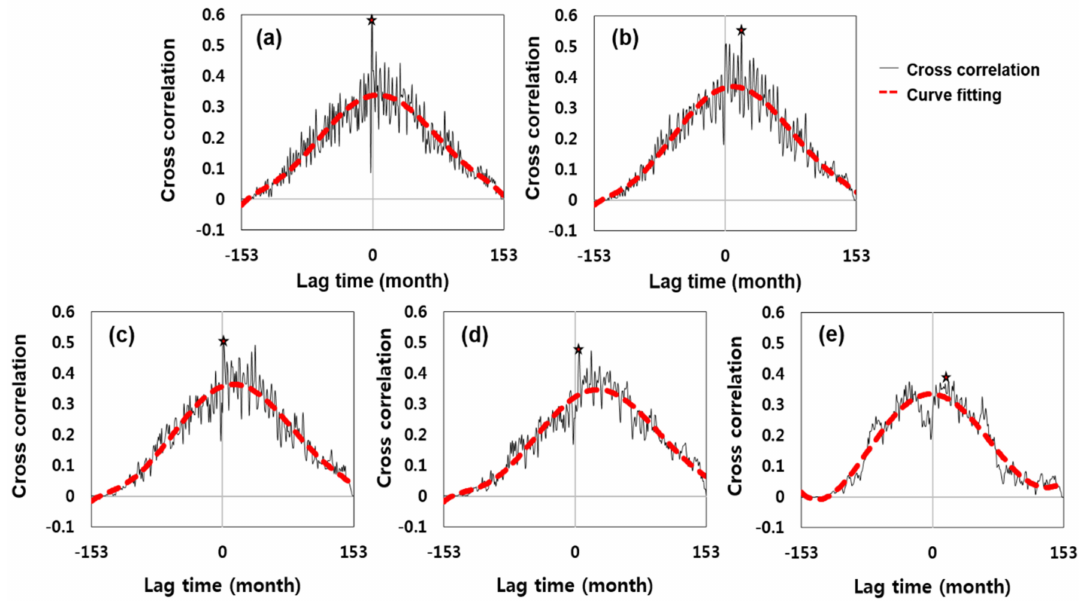
Figure 10. Cross-correlation between SPEI–SGI with lag time; ( a ) SPEI-1–SGI; ( b ) SPEI-2–SGI; ( c ) SPEI-3–SGI; ( d ) SPEI-6–SGI; ( e )